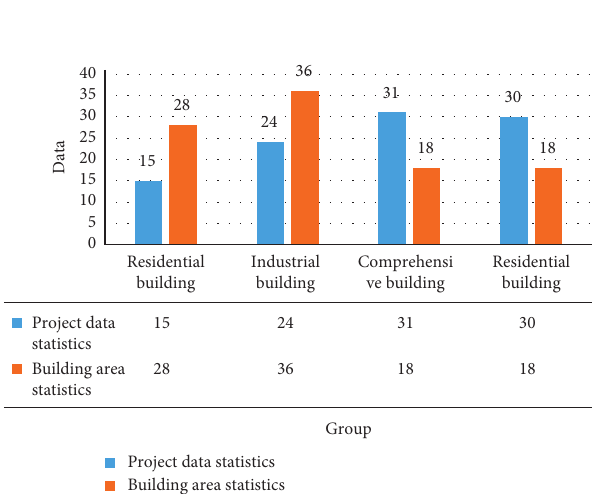
Figure 4: Proportion of green building signs in each climate